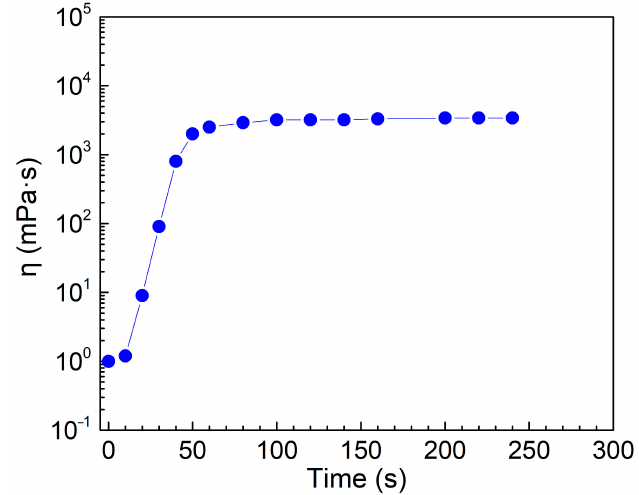
Figure 6. Change in viscosity of SA/cyclen solution (300 mM) with N 2 bubbling time for the removal of CO 2 (Temperature, 25 °C; shear rate, 10 s − 1 ; flow rate of N 2 , 0.1 L· min − 1 ).